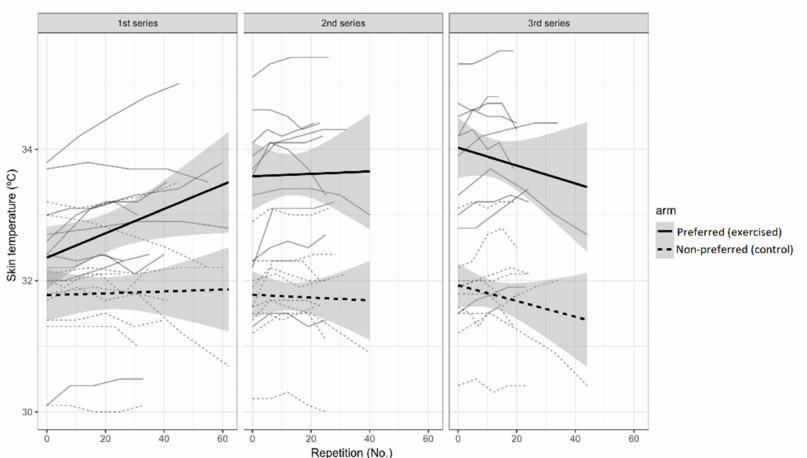
Figure 4. Skin temperature responses during exercise for the three series in both arms. For each arm, a linear trend line with a 95% CI has been added to each series